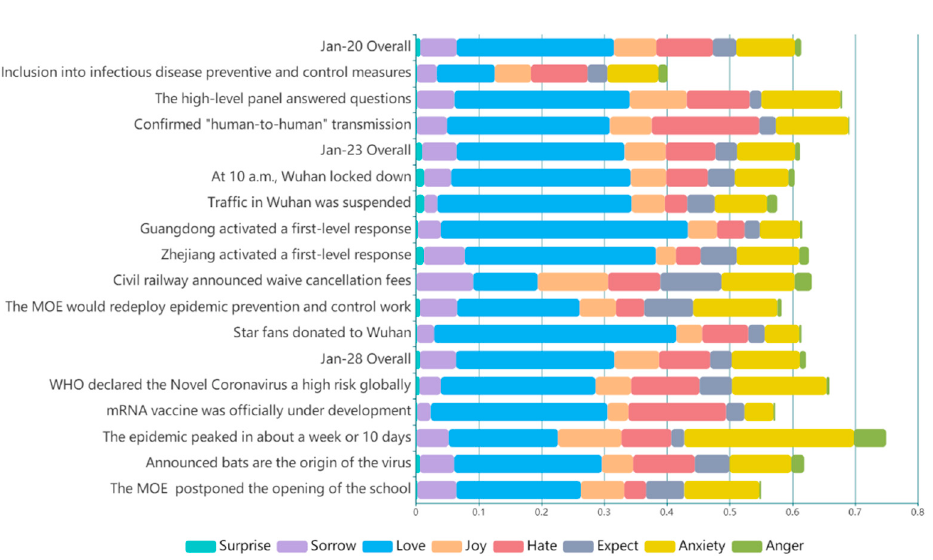
Figure 10. Emotional Distribution of the Days and Public Events.